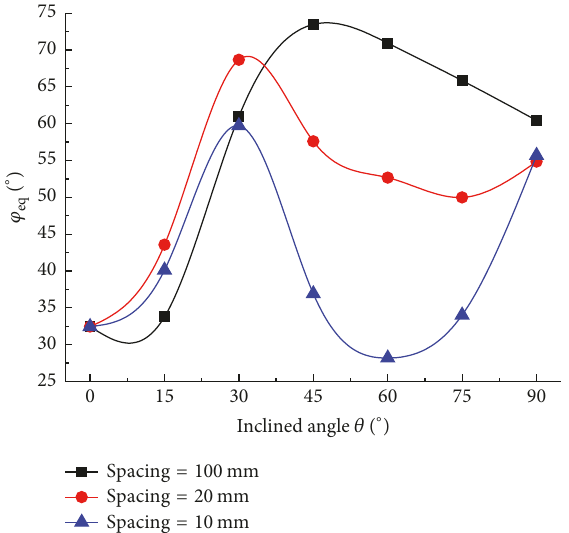
Figure 12: Equivalent internal friction angle of the specimens with various bedding plane geometries.